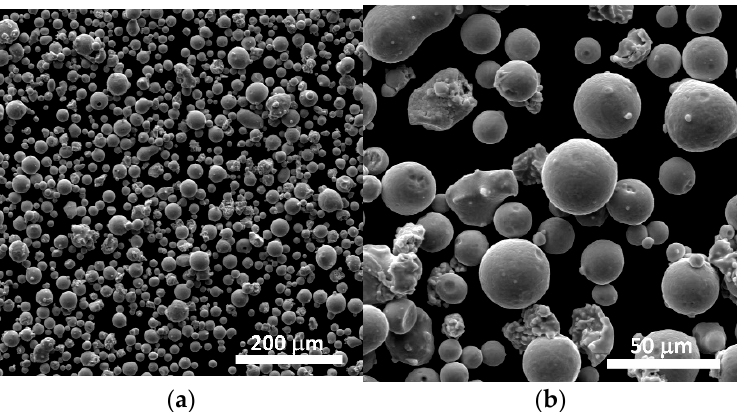
Figure 3. Morphology of the CL50WS powder used for SLM [9], ( a ) 399× SEM magnification and ( b ) 1.65k× SEM magnification.